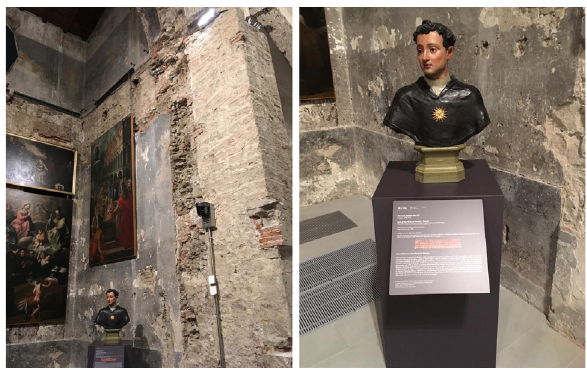
Figure 2. The chapel dedicated of San Nicola da Tolentino and the bust of the saint in the complex of